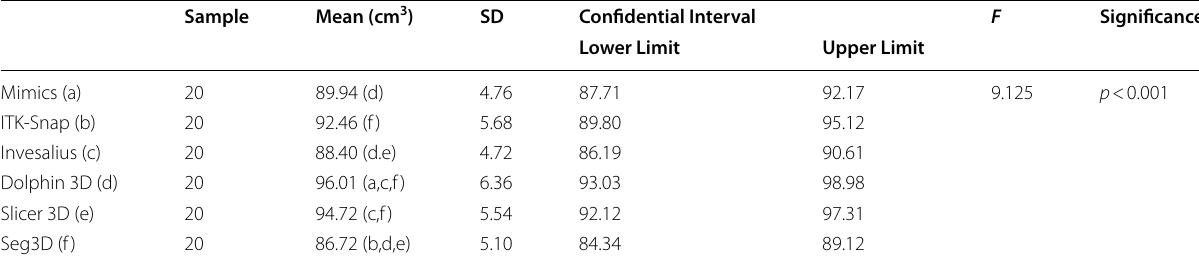
*Significance set at p < 0.05 and based on one-way analysis of variance (ANOVA) and Scheffe’s post-hoc comparisons tests; a, b, c, d, e, f comparisons